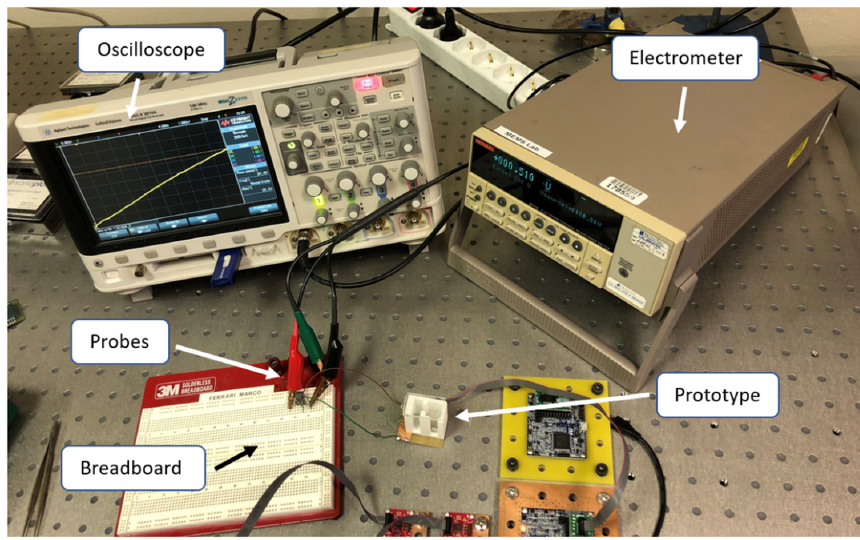
Figure 6. Experimental set up with indication of all the equipment and the prototype.